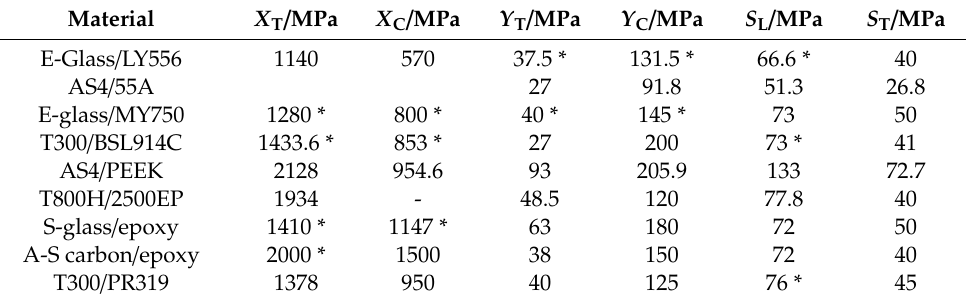
Table 1. Strength properties of composites